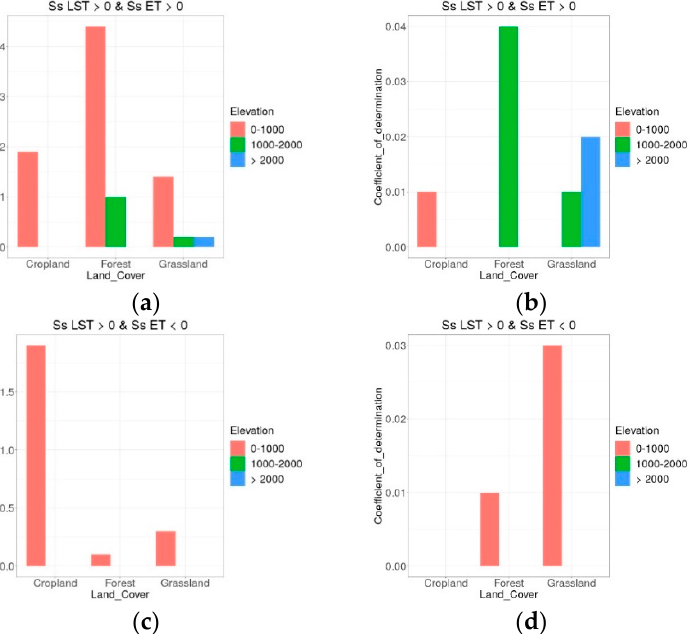
Figure 15. Percentage of area in each land cover class where LST and MOD16 ET trends overlap, per elevation ( a , c ) and corresponding r 2 ( b , d ). The combination of positive or negative ET and LST trends is indicated in the title of each plot. “Area” on the y axis is the percentage of the total area within each land cover class. Ss is the Sen’s slope of the trend at 5% significance from 2003 to 2019. For SSEBop, small areas showed correspondence between positive LAI and ET trends in all the land cover-altitude classes, with very low correlation (Figure 16). Areas with negative LAI and ET trends were found only for croplands and grasslands at low elevations and showed very low correlation. Positive tp trends corresponded to positive ET trends